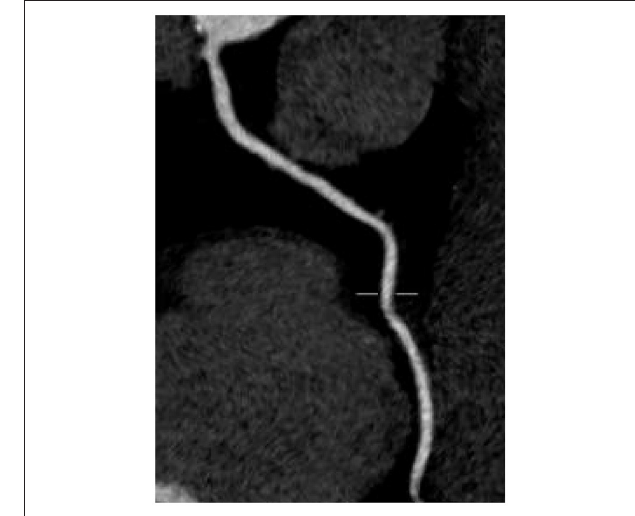
FIGURE 1 | Typical image of left anterior descending curved planar reconstruction in the control group.